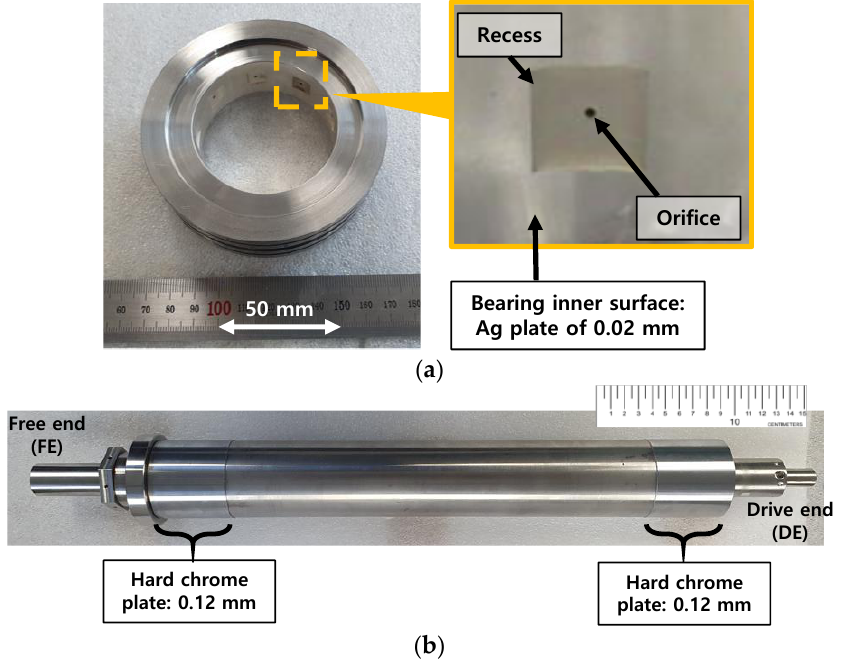
Figure 2. Photographs of test hydrostatic baring and test rotor. ( a ) Test bearing. ( b ) Test rotor. Table 1. Measured dimensions and physical properties of test rotor and test bearing.